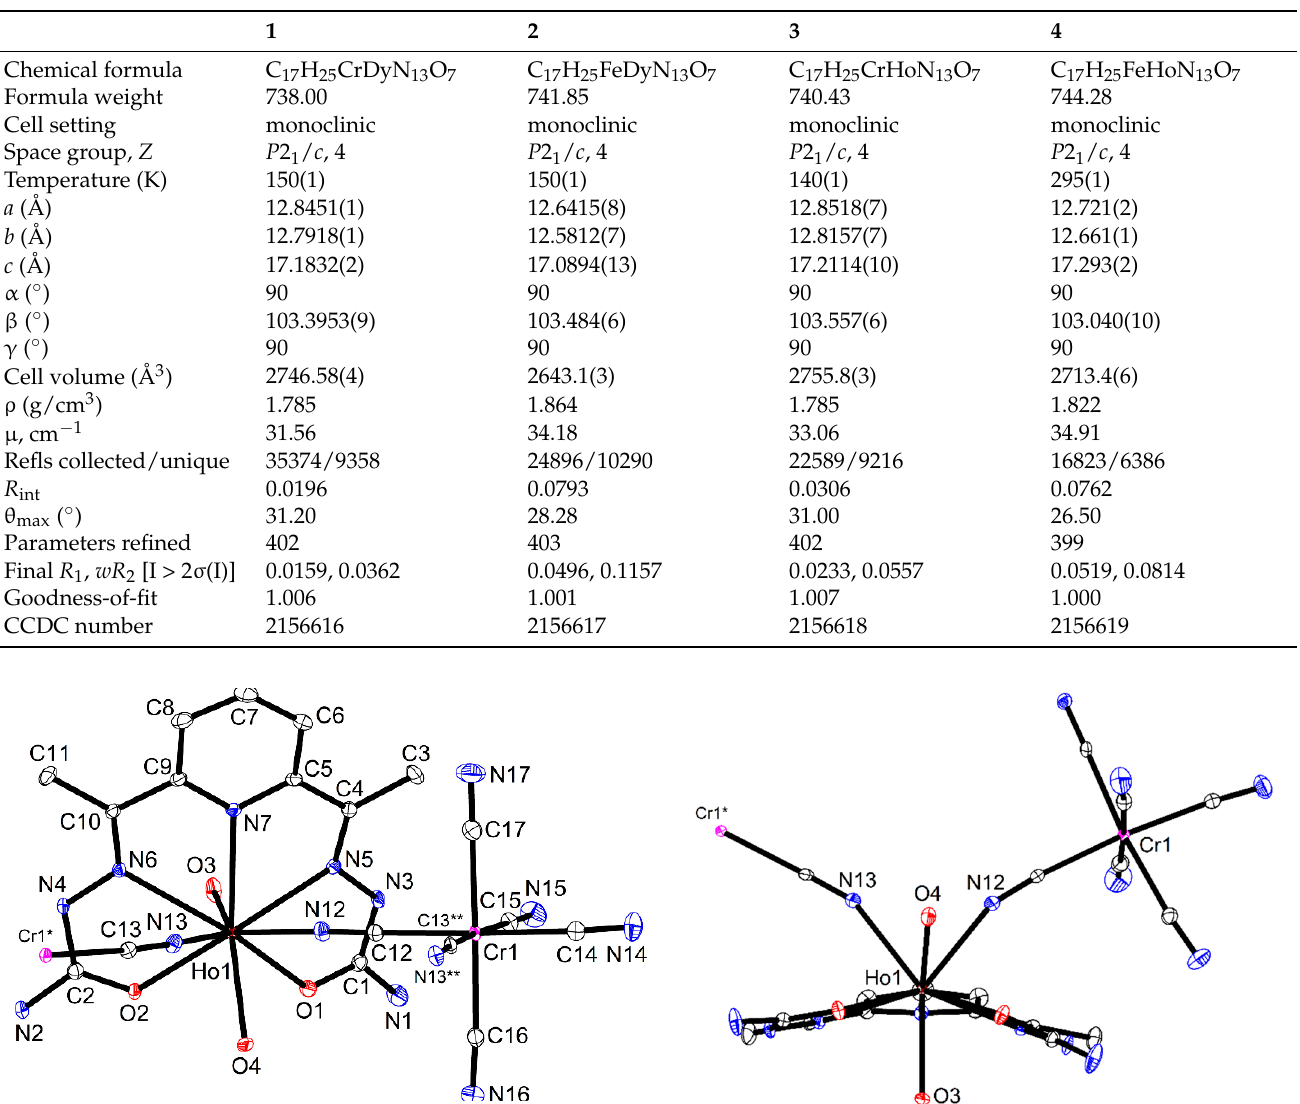
Table 1. Crystal data and structural refinement parameters for the complexes 1 – 4 .